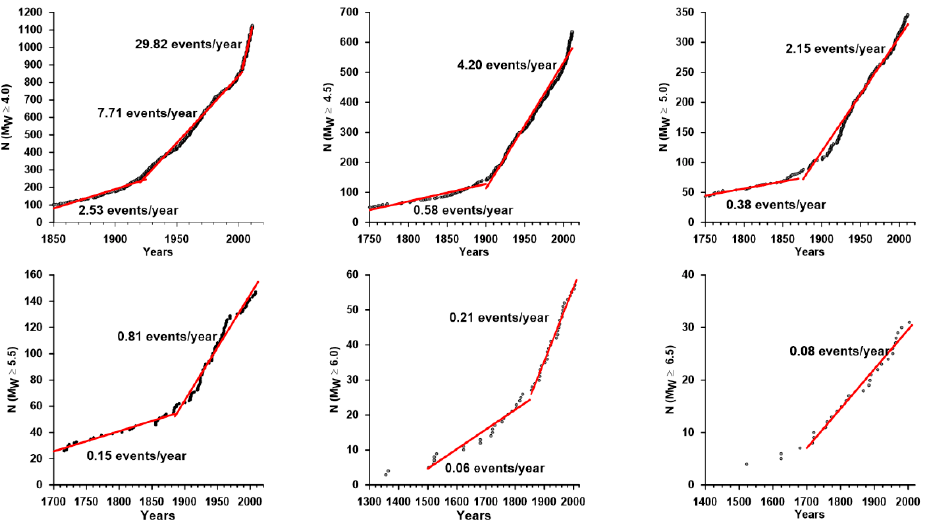
Figure 2. Cumulative number of earthquakes above magnitudes Mw 4.0, 4.5, 5.0, 5.5, 6.0 and 6.5 vs. time (black circles). The straight lines (in red) show linear fits.